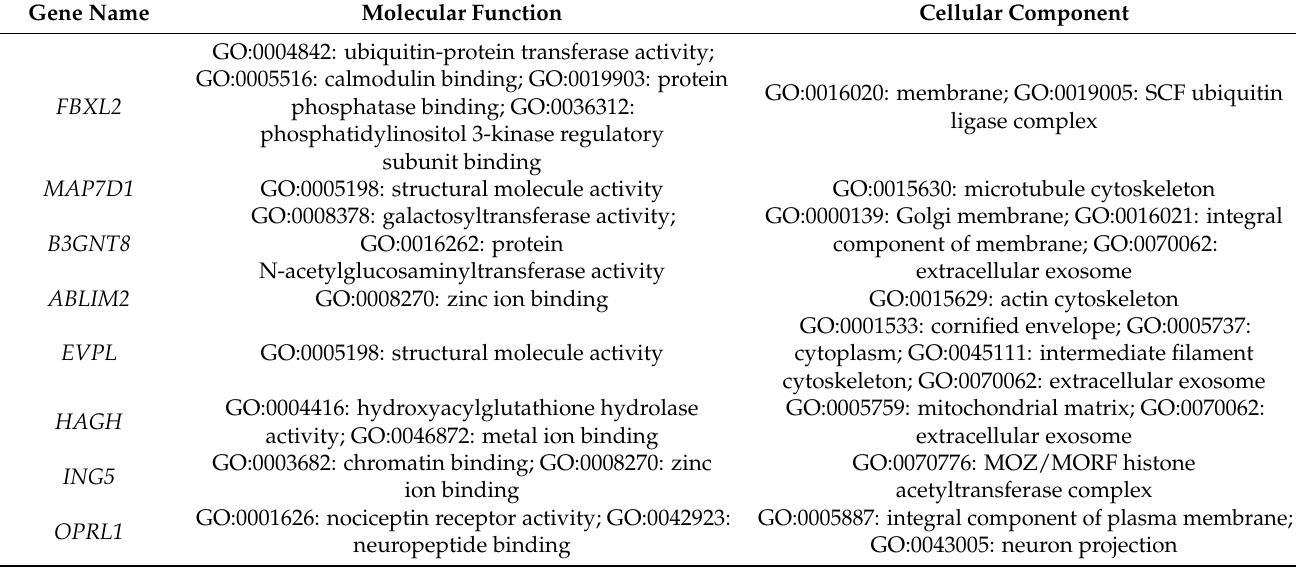
Table 6. Gene ontology DMRs identified in CON vs. OVER